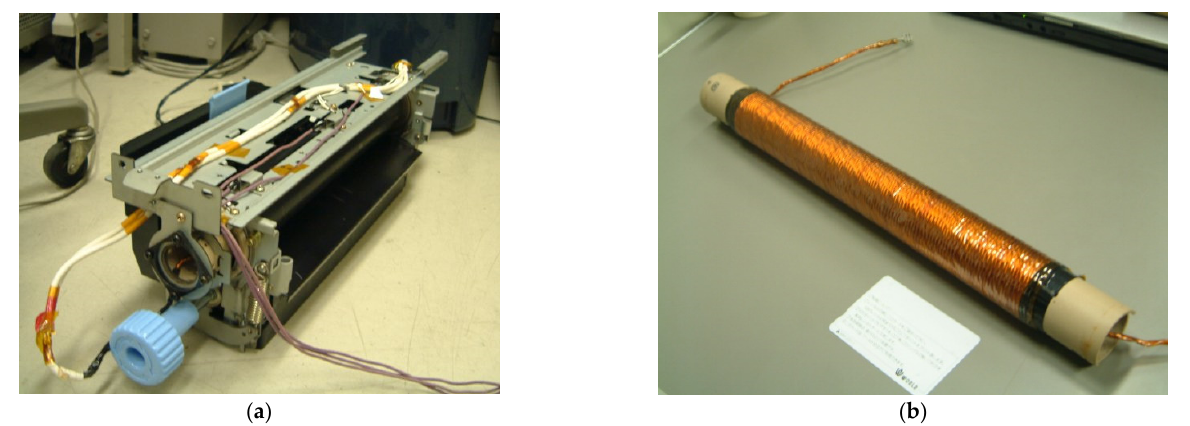
Figure 6. IH fixed roller and heating coil. ( a ) Fixed roller. ( b ) Heating coil.